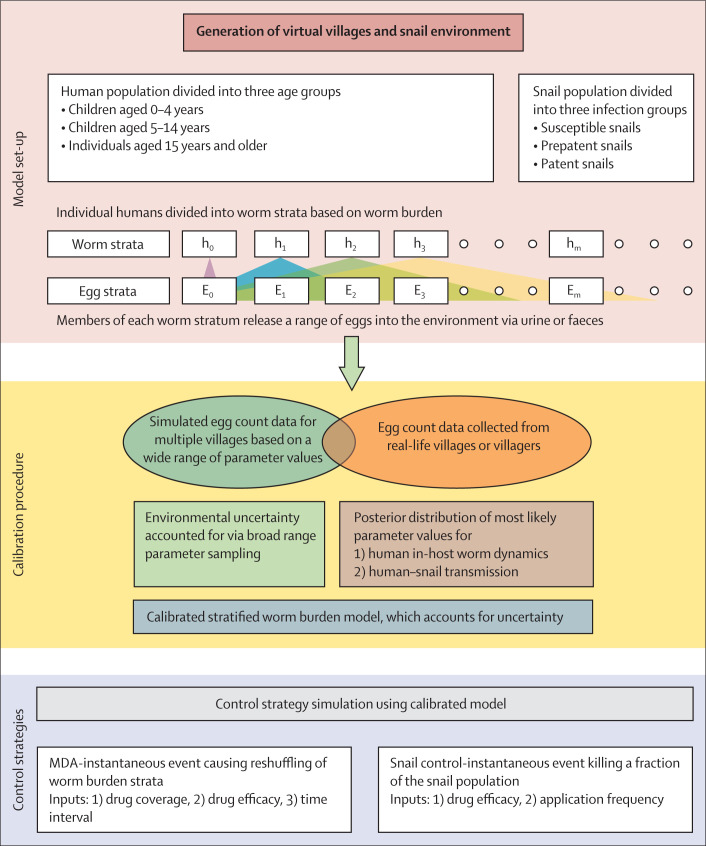
Stratified worm burden modelling approachMDA=mass drug administration. h=human. E=egg. m=placeholder signifying integral sequence.